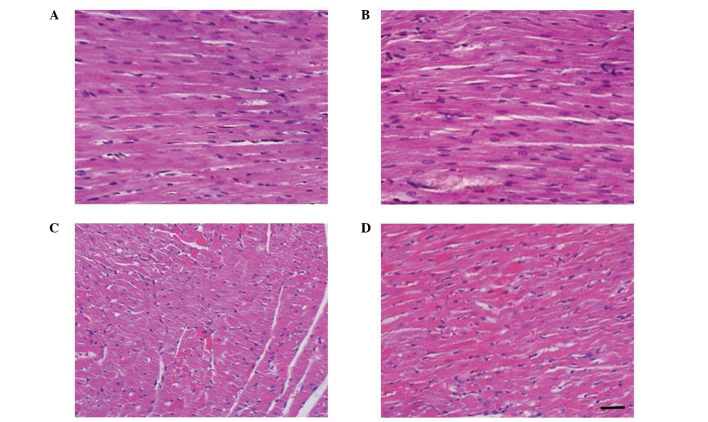
Histopathological analysis of rat myocardium. (A) Normal appearance of myocardial tissue in control rats; (B) healthy myocardium from positive control rats (EGCG alone); (C) myocardial infarction in high-cholesterol (HC)-fed rats; and (D) HC+EGCG treatment group: EGCG prevented HC-induced myocardial infarction. Scale bar, 100 μm. EGCG, epigallotechin-3-gallate.